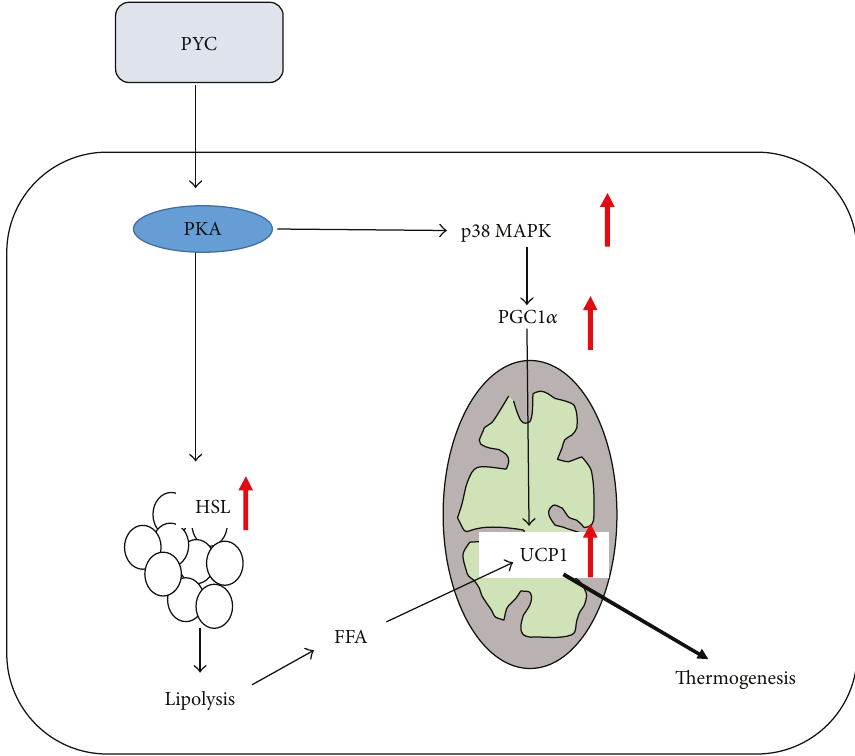
Figure 6: The likely mechanism underlying the e ff ect of PYC on the browning of WAT. PYC may stimulate UCP1 expression through the PKA-p38 MAPK-PGC1 α pathway and the PKA-HSL